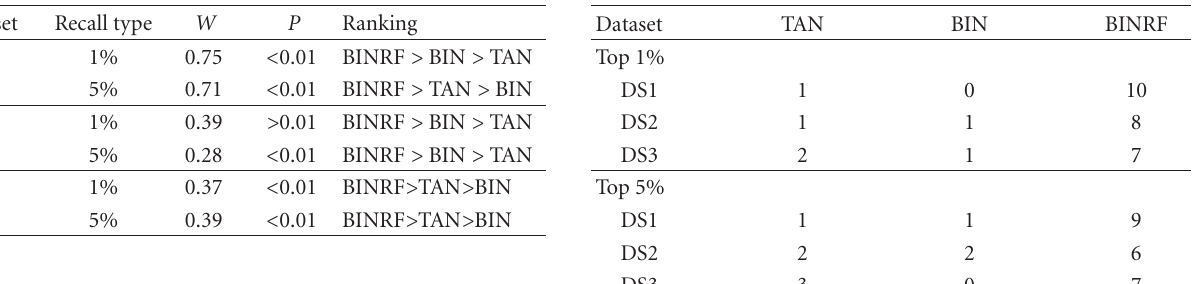
Table 8: Number of ( ∗ and ∗∗ ) cells for mean recall of actives using di ff erent search models for DS1–DS3 Top 1% and